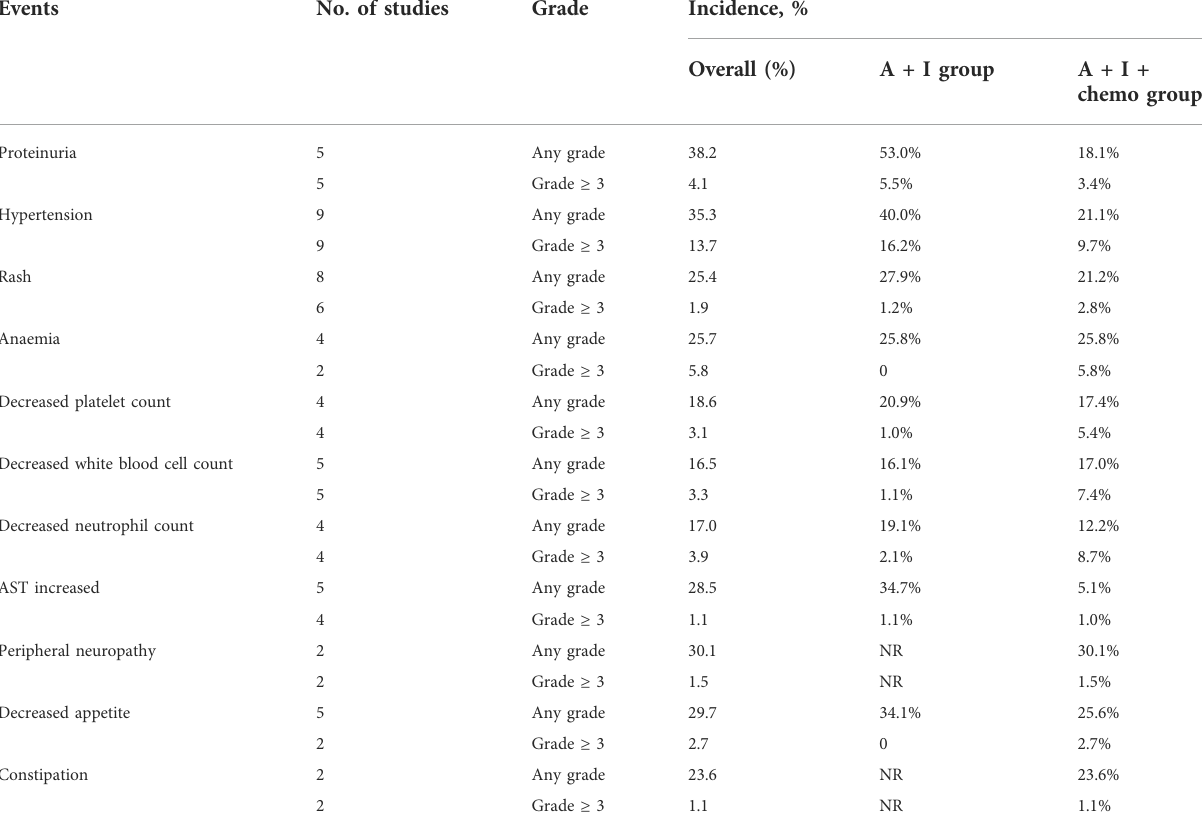
TABLE 4 Adverse events.